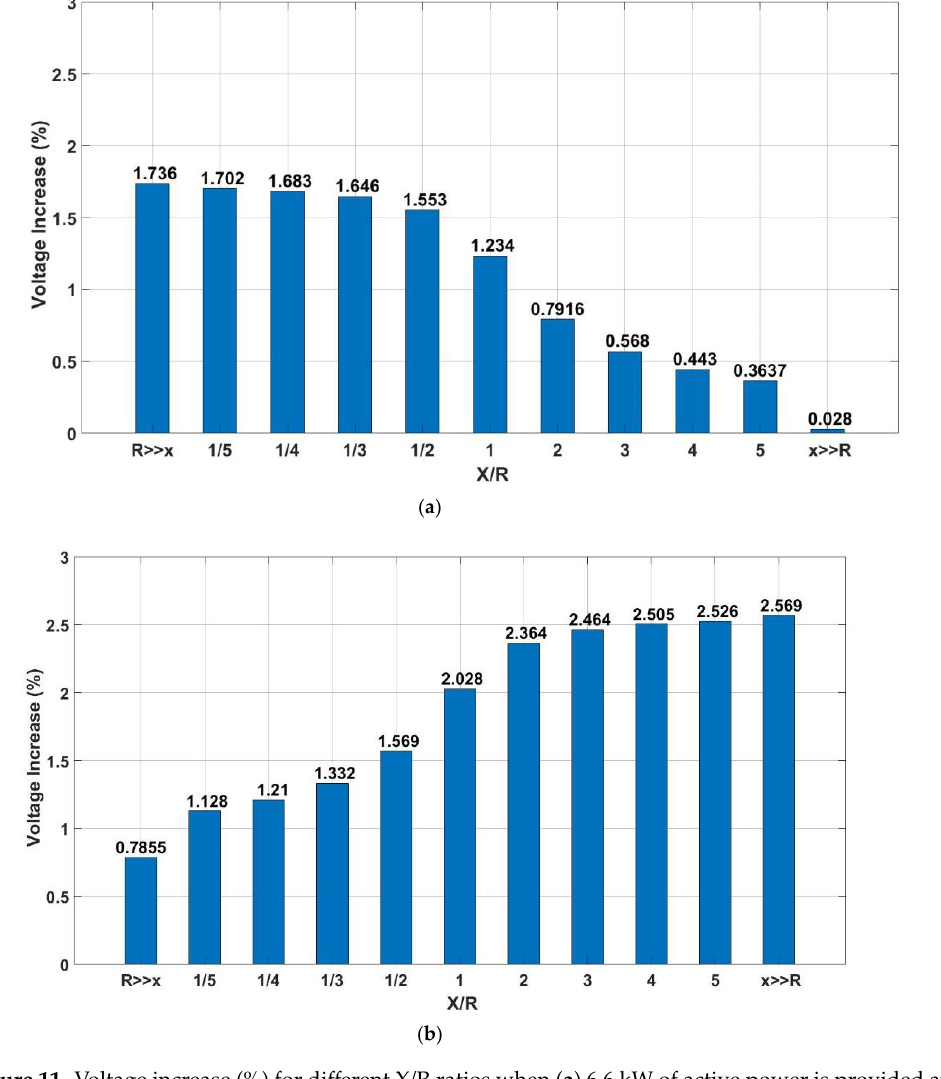
Figure 11. Voltage increase (%) for different X/R ratios when ( a ) 6.6 kW of active power is provided and ( b ) 6.6 kVAr of reactive power is provided.